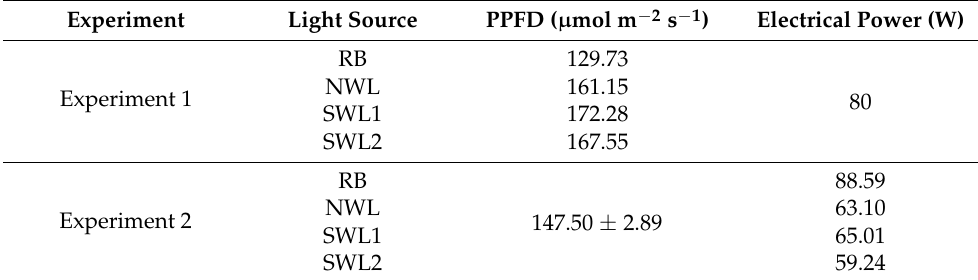
this study (experiment 1: same electrical power; experiment 2: same